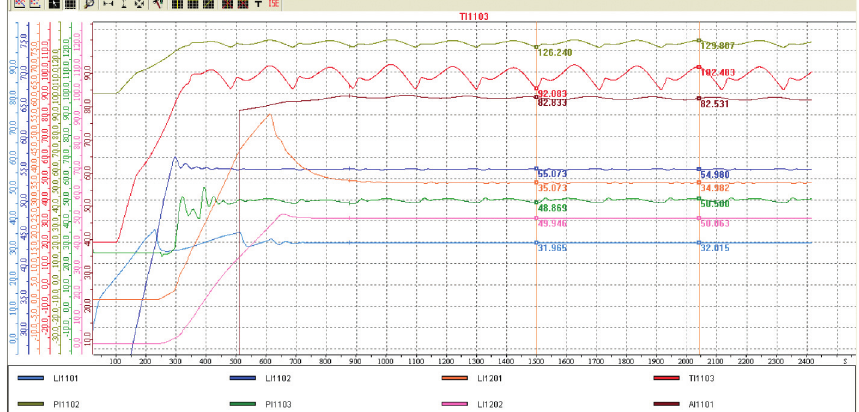
Figure 9: Smith forecast compensation system